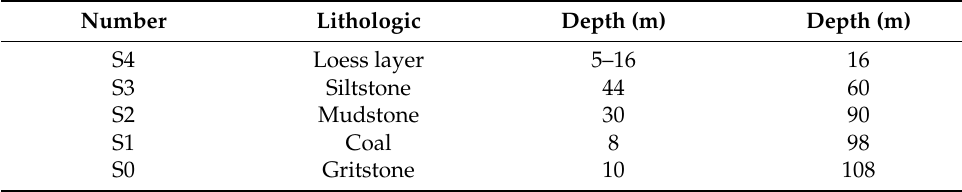
Table 1. Composition of coal seam overburden.